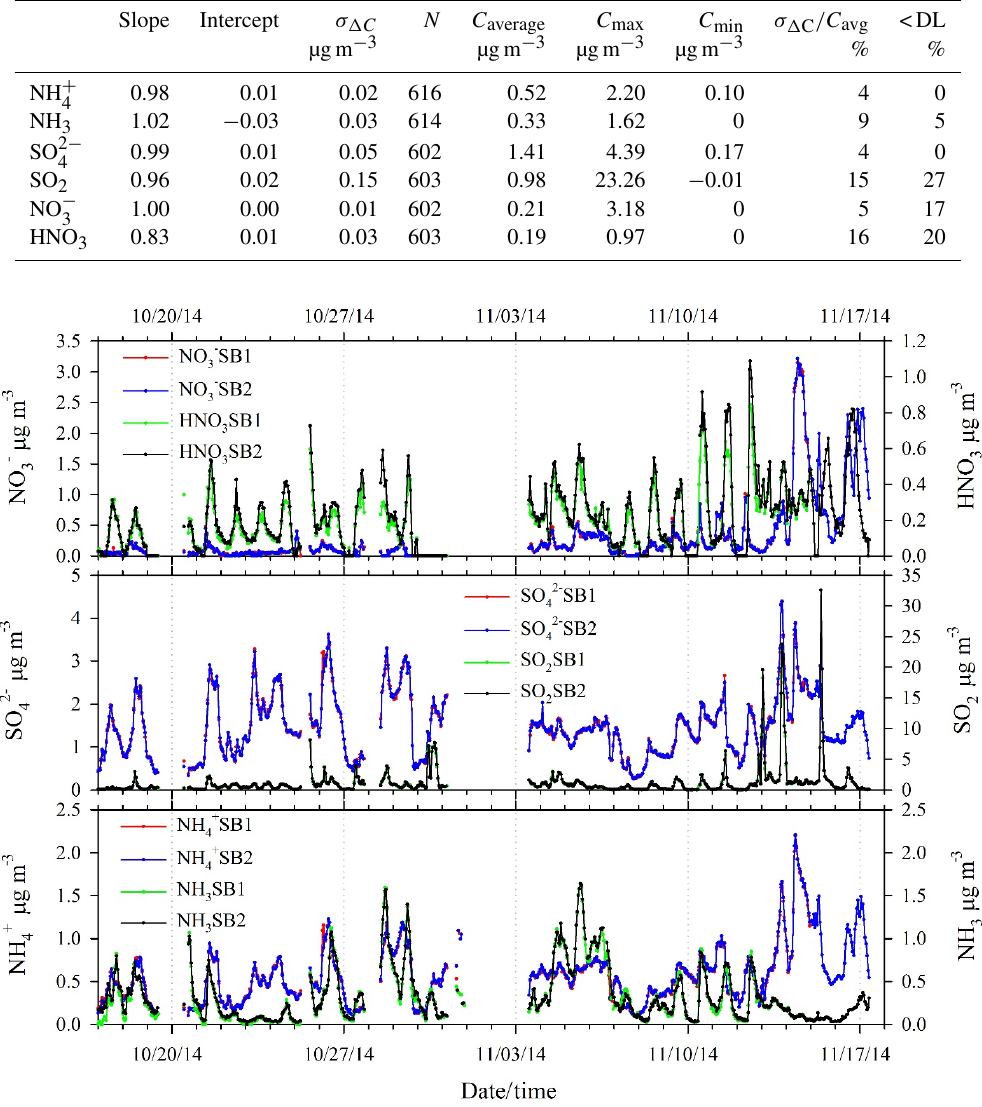
Figure 2. Time series of concentrations of particulate NO − sample boxes 1 (SB1) and 2